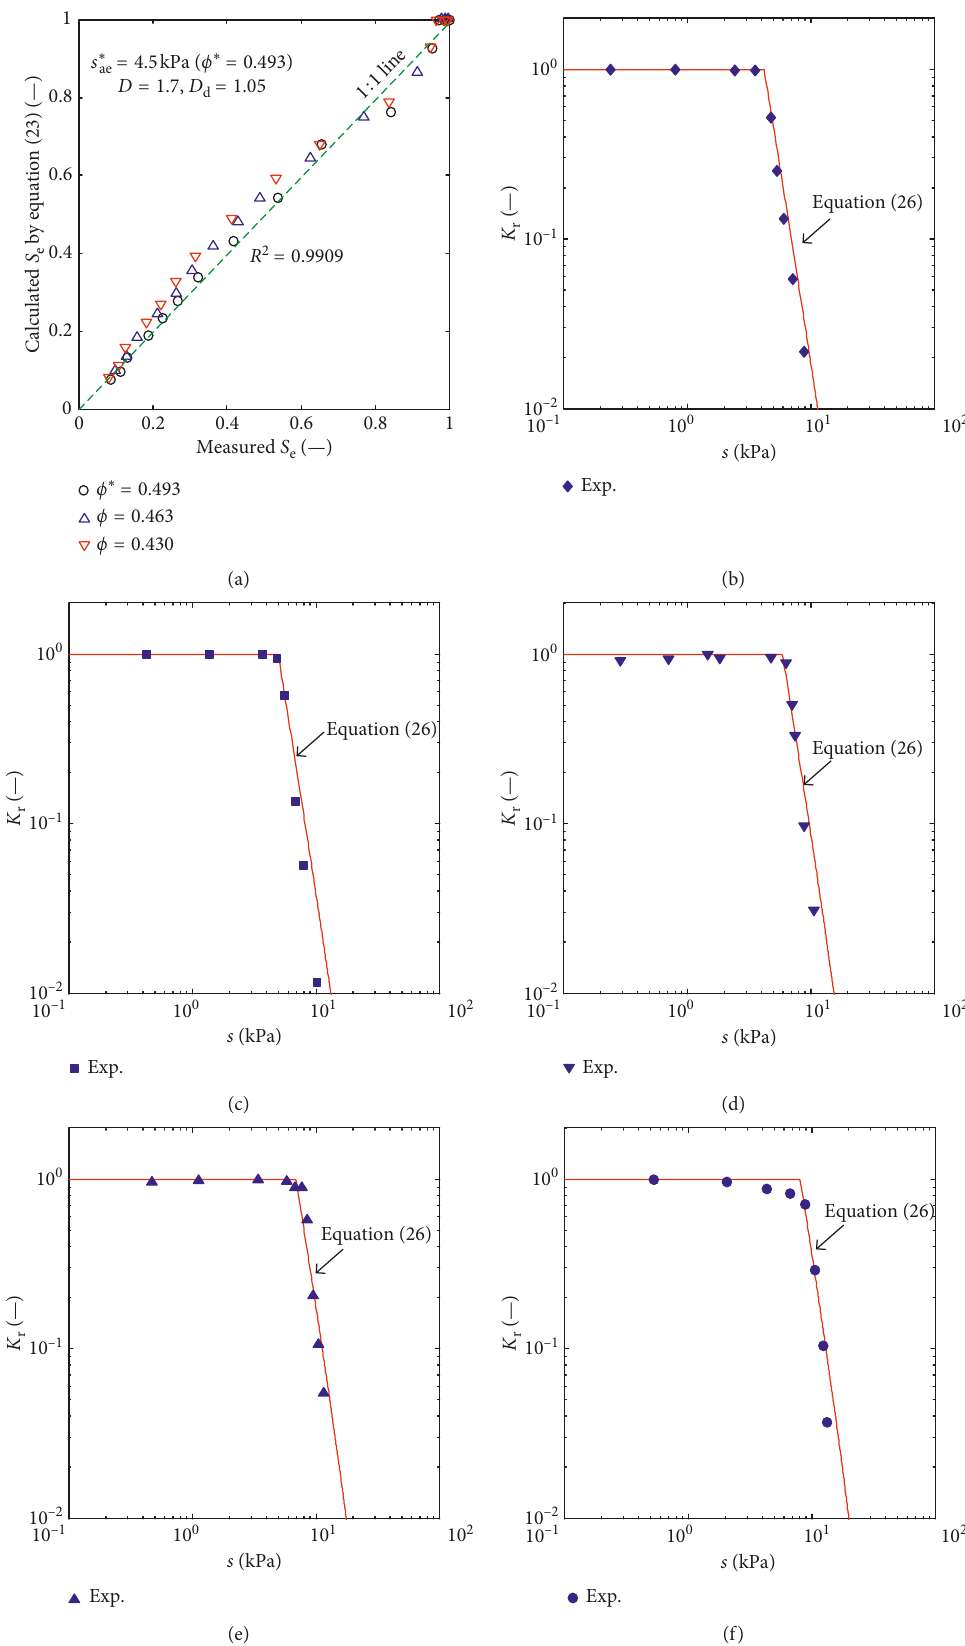
Figure 6: Comparison between measured and predicted SWRCs and HCFs for the Touchet silt loam: (a) SWRCs, (b) HCF ( ϕ � 0.503), (c) HCF ( ϕ � 0.478), (d) HCF ( ϕ � 0.449), (e) HCF ( ϕ � 0.423), and (f) HCF ( ϕ �